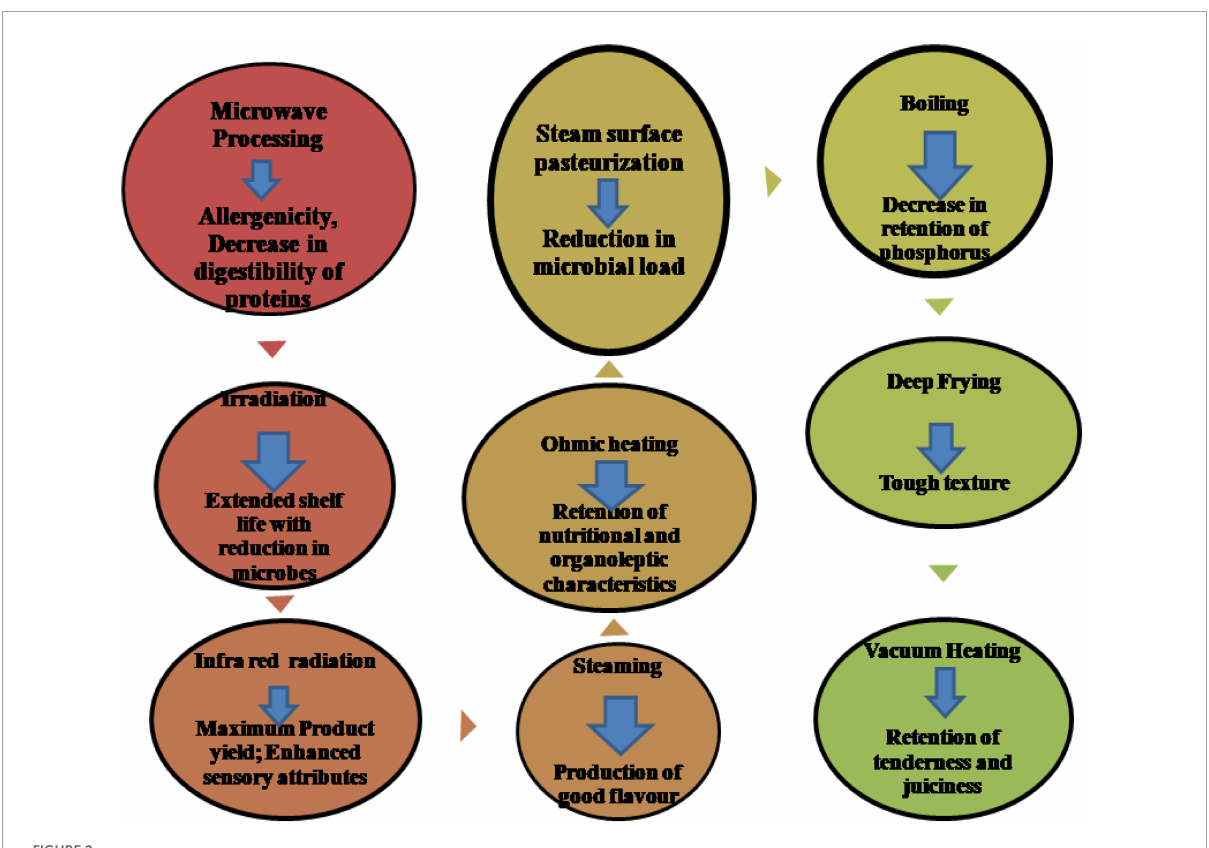
FIGURE2 Various changes occur during meat